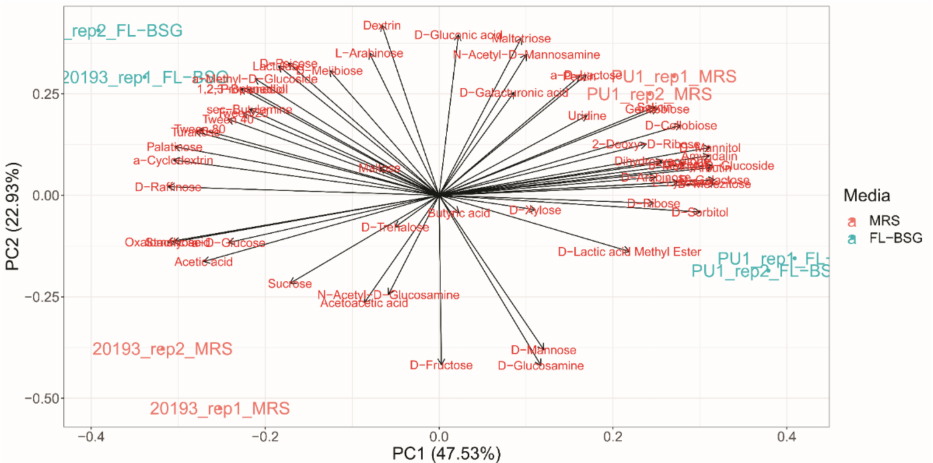
Figure 2. Principal component analysis (PCA) of the area under the curve (AUC) computed from phenotype microarray data for and Lactiplantibacillus plantarum PU1 and Leuconostoc. pseudomesen- teroides DSM 20193 cultivated in Finnish brewers’ spent grain (FL-BSG) and MRS at 30 ◦ C for 14 and 8 h. Loadings evidence substrate consumption across the PCA